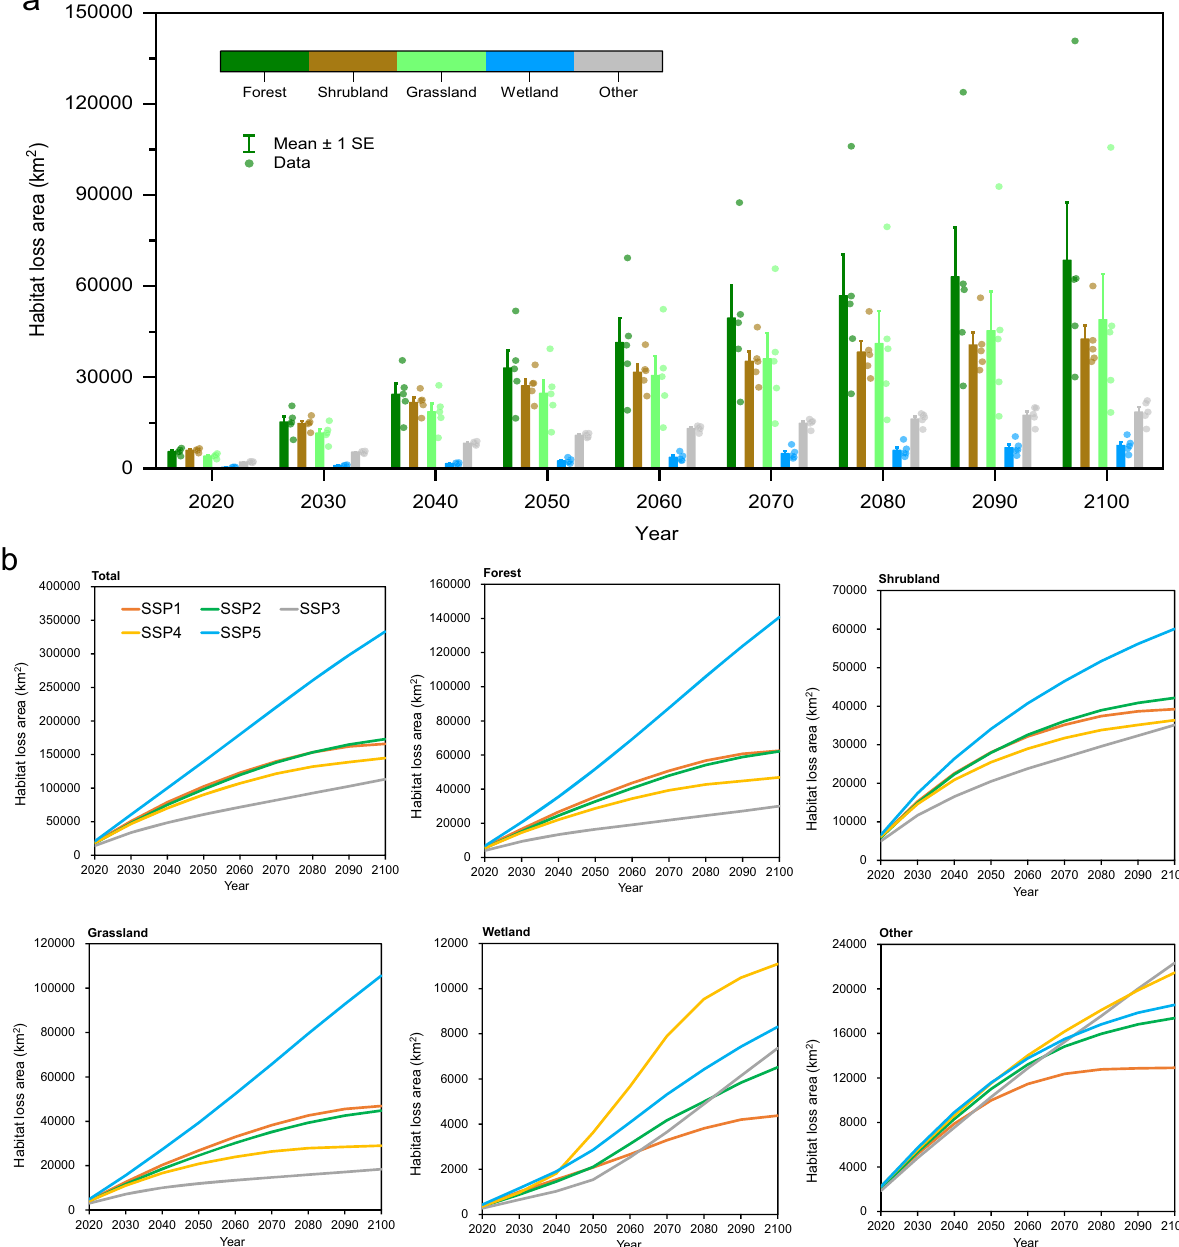
Fig. 1 Future direct habitat loss due to urban expansion under SSP scenarios. a The habitat loss by 2100 for each habitat type. Bars indicate the mean habitat loss area ( fi ve scenarios) for each habitat type. Error bars represent mean values ± 1 SEM for the loss of each habitat type under fi ve scenarios, n = 5 scenarios. Points represent data in fi ve scenarios. b The losses in total area, forest, shrubland, grassland, wetland, and other